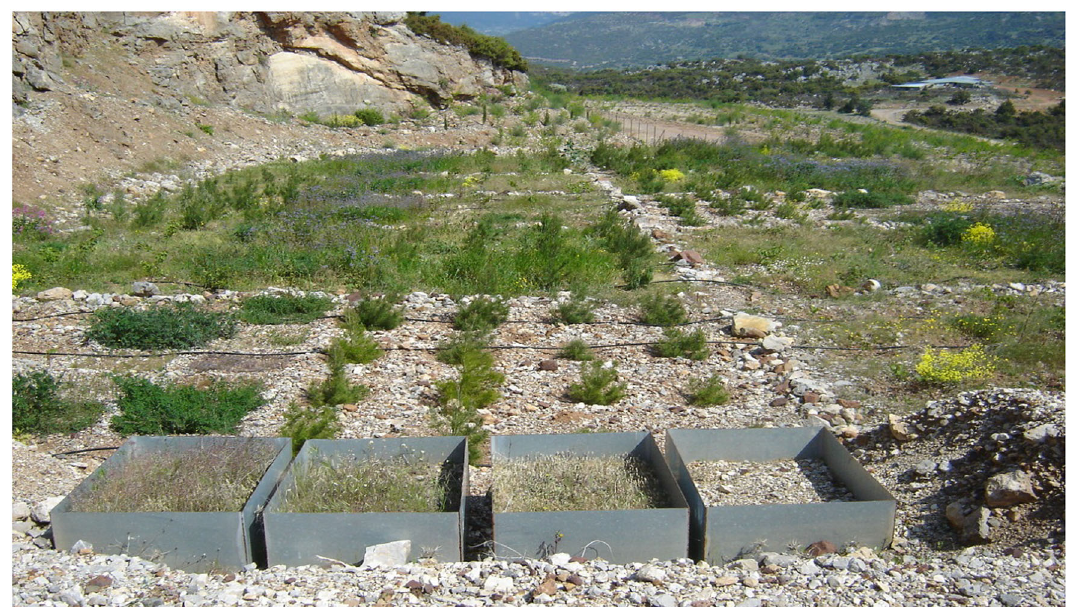
Fig. 3 Experiment with sewage sludge application on limestone mining spoils from bauxite mining activities in Rodia area, central